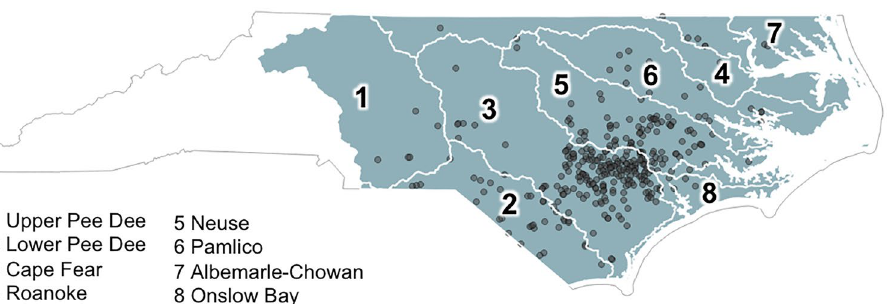
Figure 3. Swine waste lagoon sites (n = 340) randomly selected to compose the validation set. The sample is spread across the eight HUC6 watersheds in the study area (watershed boundaries shown as white lines and labelled with numbers). This figure was produced using QGIS version QGIS 3.18.3 (https:// www. qgis.